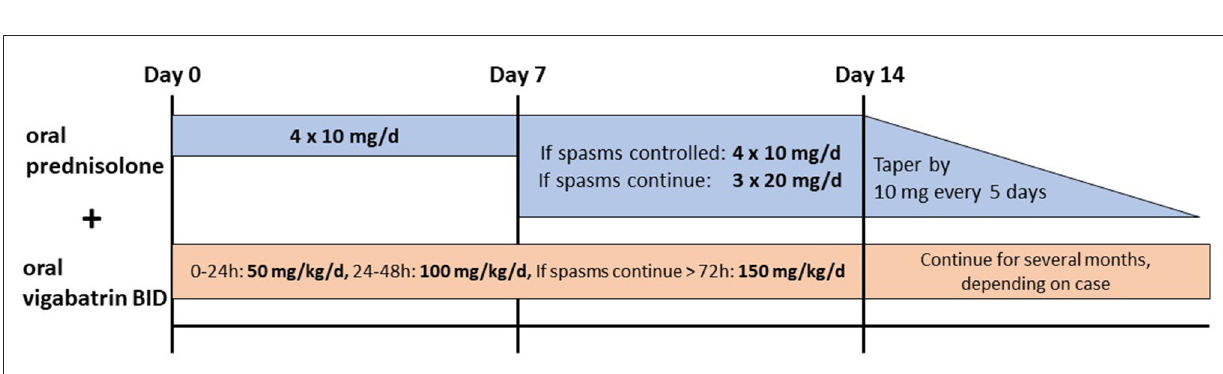
20 mg, three times/day. In addition, oral vigabatrin is started with 50 mg/kg/day and increased to 150 mg/kg/day in two doses/day within 4 days if spasms do not cease on day 7 or reappear (26).